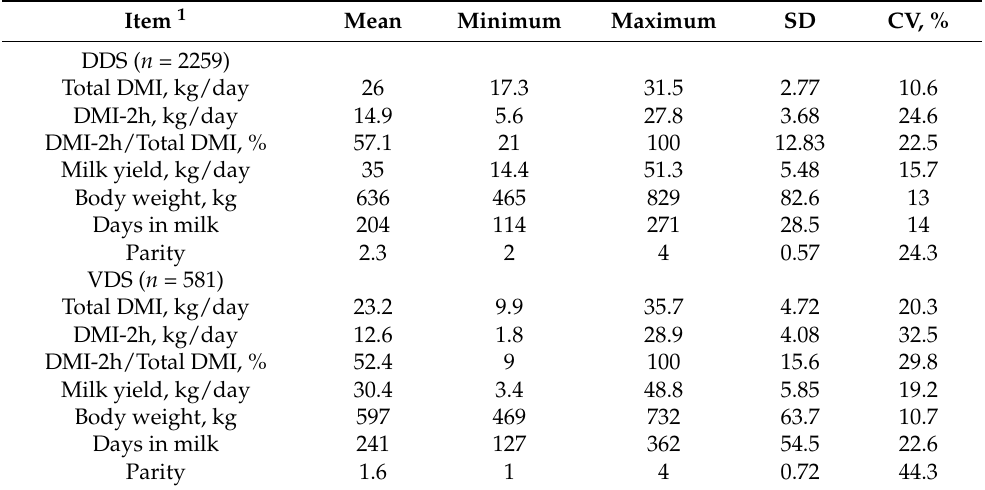
Figure 1. Dry matter intake at various times of the day of dairy cows (development dataset). Table 1. Descriptive statistic of all data in development dataset (DDS) and validation dataset